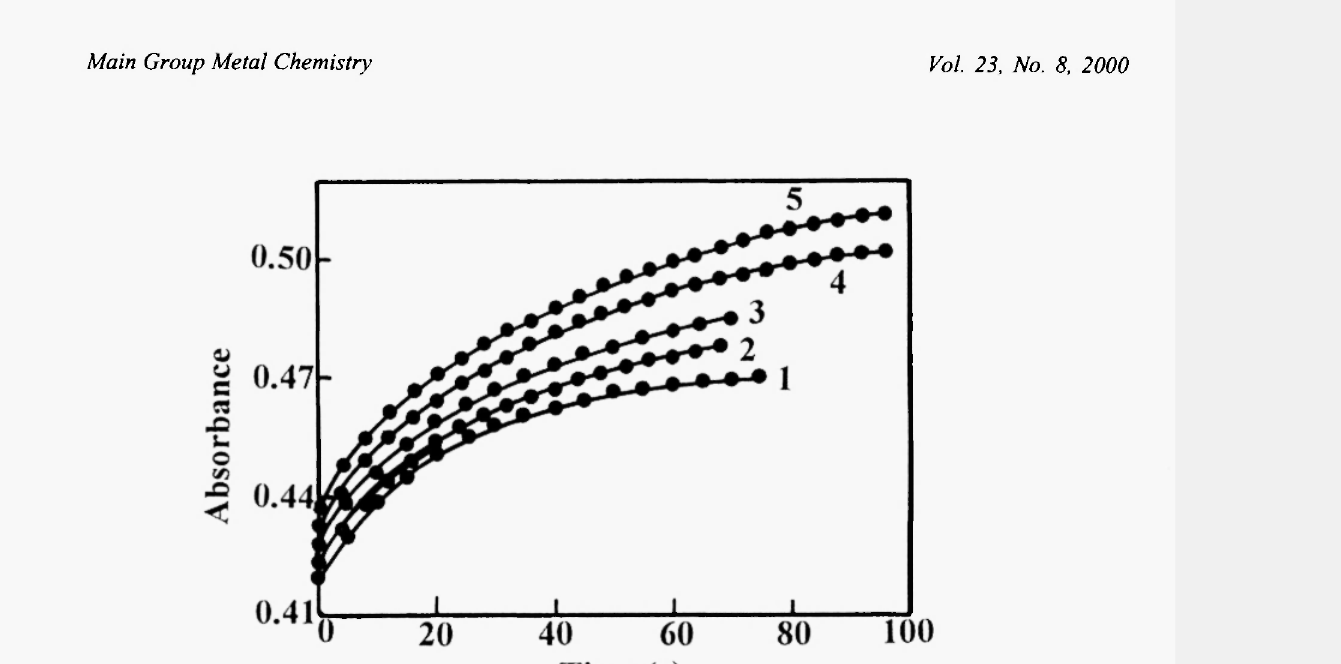
Fig. 1. Absorption-time plots for the dissociation of Ba 2+ -C222 cryptate in the presence of murexide and excess K' ion at 308 Κ in different DMSO-AN mixtures. X AN : 1, 0.0; 2, 0.13; 3, 0.25; 4, 0.37; 5, 0.47. Table 1. Dissociation rate constants at various temperatures and activation parameters for Ba 2 *-C222 cryptate in different DMSO-AN mixtures T(K) XAN